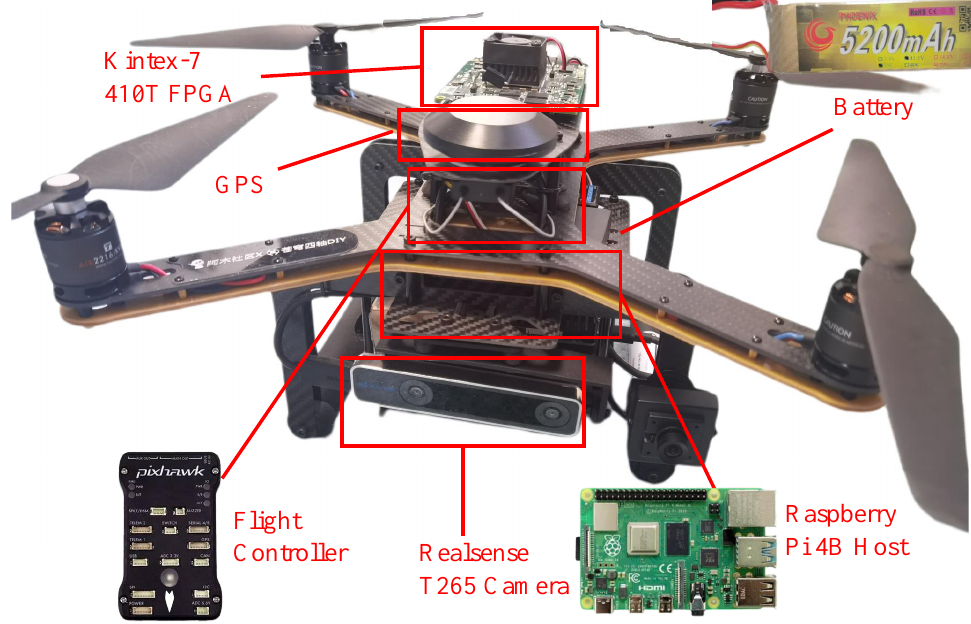
Figure 4. The proposed intelligent